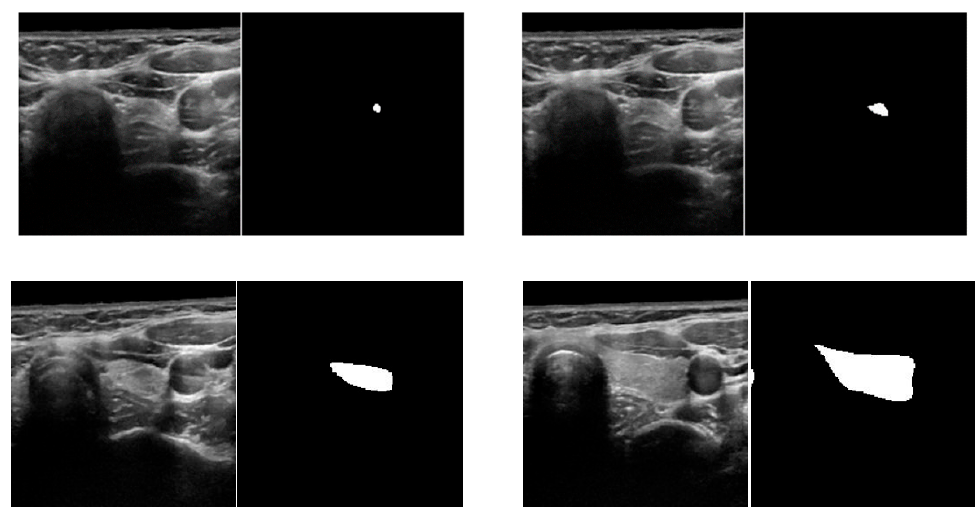
Figure 7. Examples of images with corresponding ground-truth thyroid region in 3DThyroid dataset. Table 2. Details of the TDID dataset .